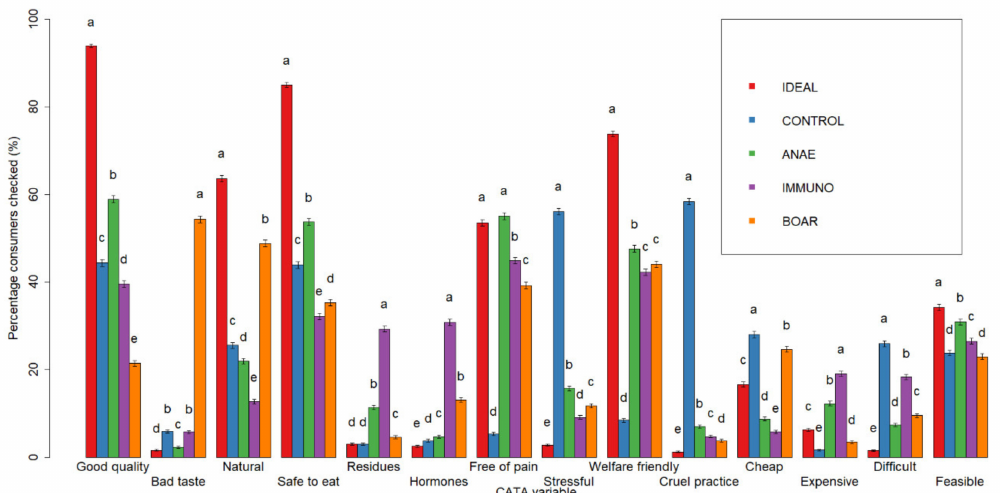
Figure 4. Frequence of Check-All-That-Apply (CATA) scoring of the ideal piece of pork (IDEAL), castration without pain relief (CONTROL), castration with anaesthesia (ANAE), immunocastration (IMMUNO), and no castration (BOAR). a–e di ff erent superscripts indicate significant di ff erences between alternatives per CATA item ( p <